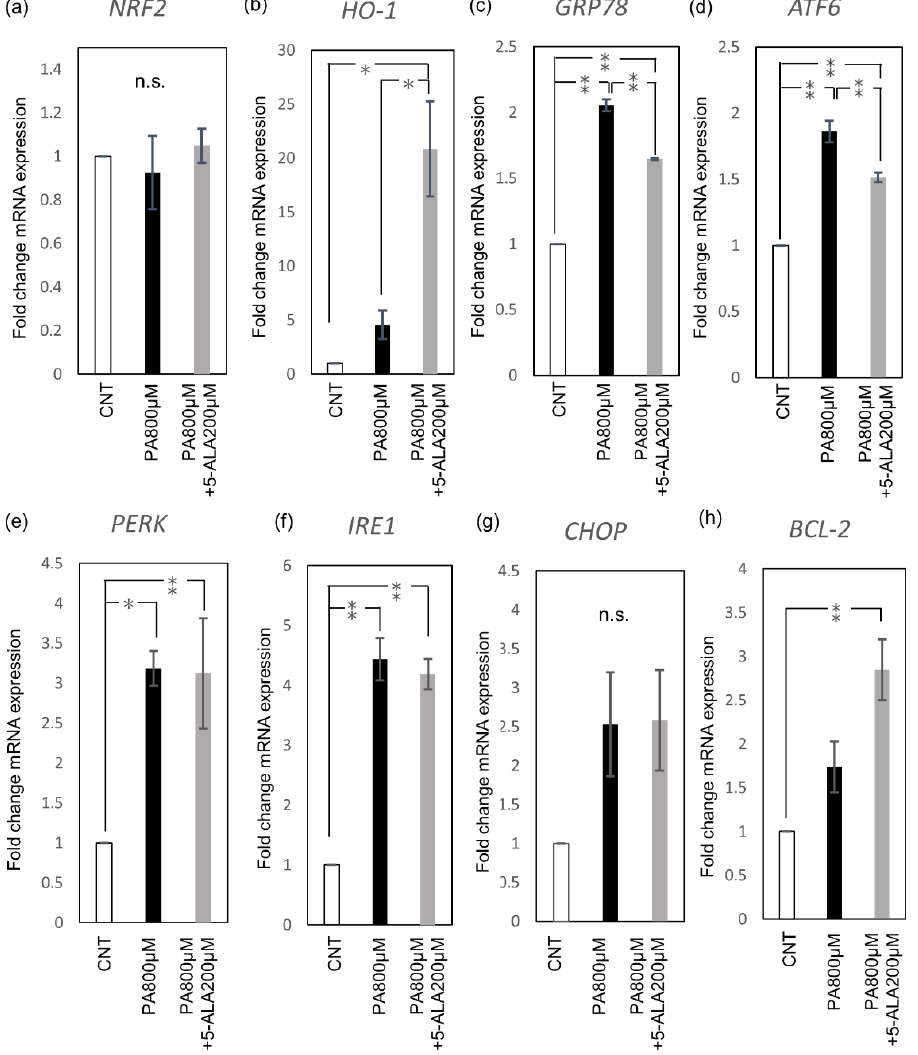
Figure 2. Redox and ER stress-associated gene expression. Huh-7 cells were treated with 1% BSA as the control and 800 μ M of palmitic acid with or without 200 μ M of 5-ALA for eight hours as the treatment groups. ( a ) NRF2 , ( b ) HO-1 , ( c ) GRP78 , ( d ) ATF6 , ( e ) PERK , ( f ) IRE1 , ( g ) CHOP , and ( h ) BCL-2 expression. The results were expressed as the ratio compared with the control. Bars indicate average ± SEM. * p < 0.05, ** p < 0.01. CNT, control; PA, palmitic acid; NRF2 , nuclear factor erythroid 2-related factor 2; HO-1 , heme oxygenase; GRP78 , Glucose-regulated protein 78; ATF6 , activating transcription factor 6; PERK , PKR-like endoplasmic reticulum kinase; IRE1 , inositol-requiring en-